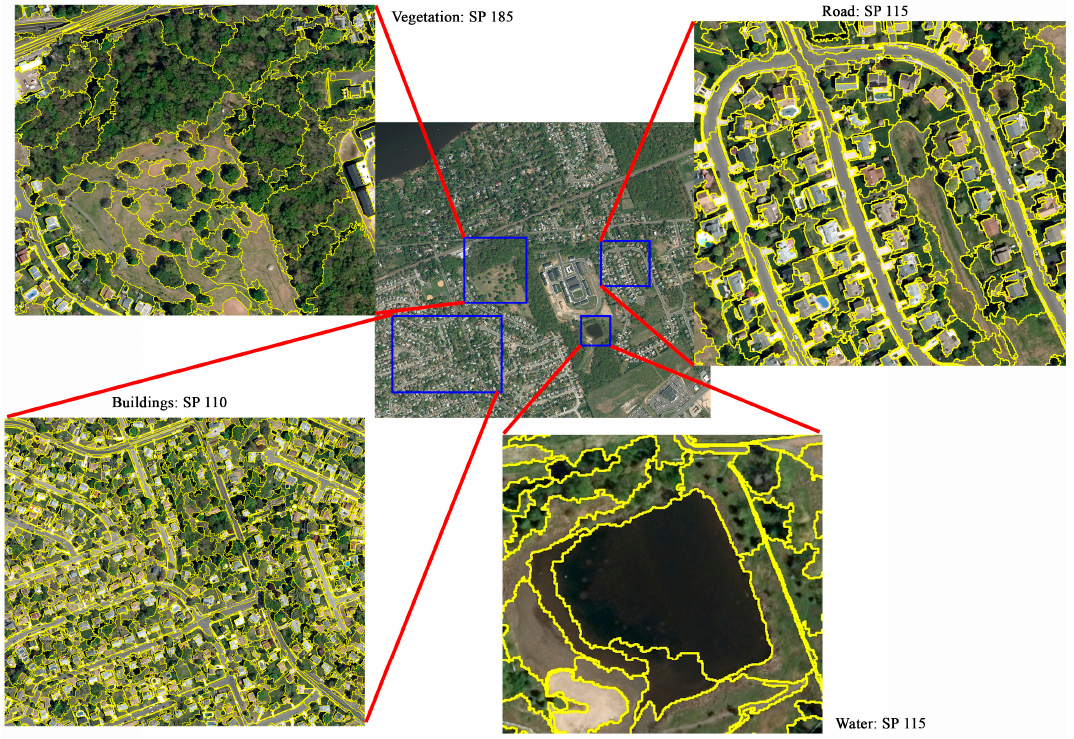
Figure 4. Segmentation results of the building, vegetation, road, and water classes in the 30-cm test image.